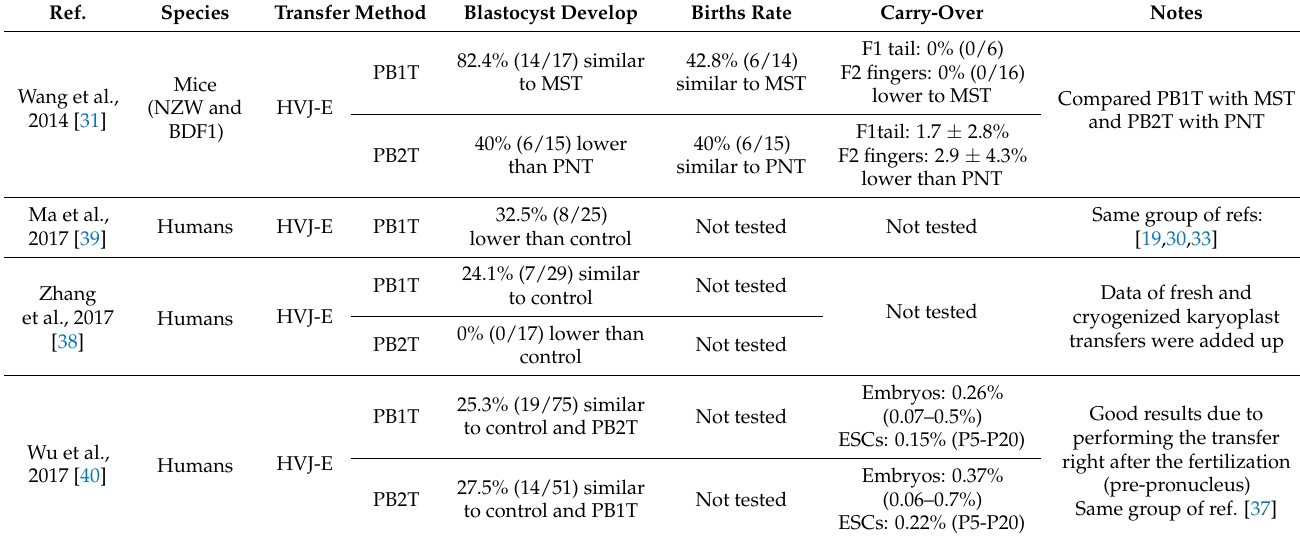
Table 7. Results of PBT in animals and